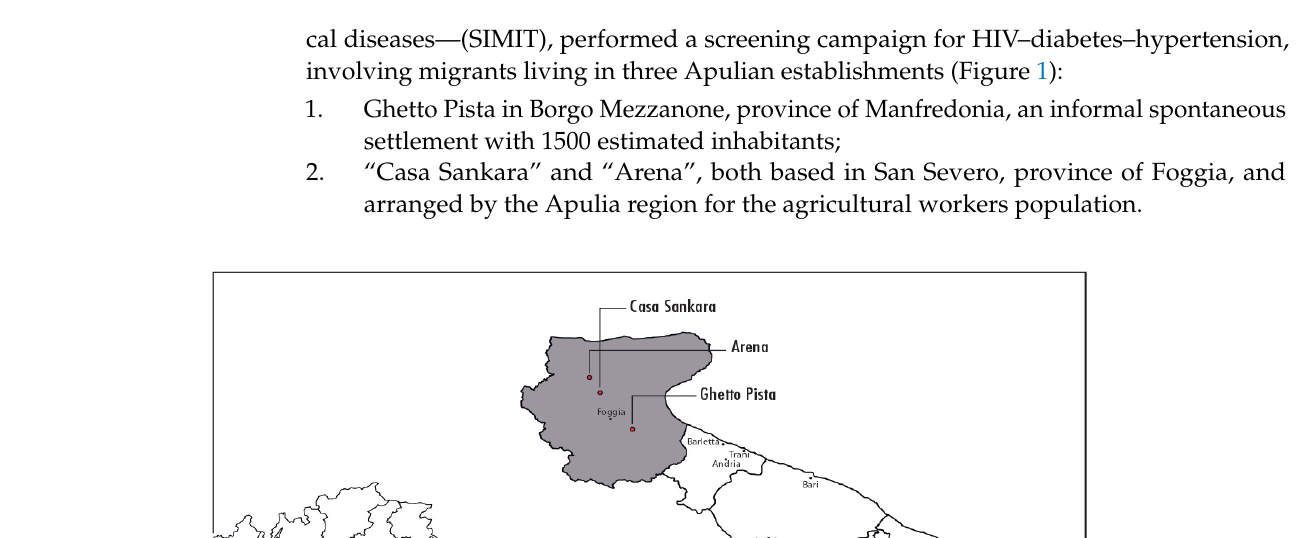
Figure 1. Localization of ghettos in Apulia region and countries of origins of migrants.